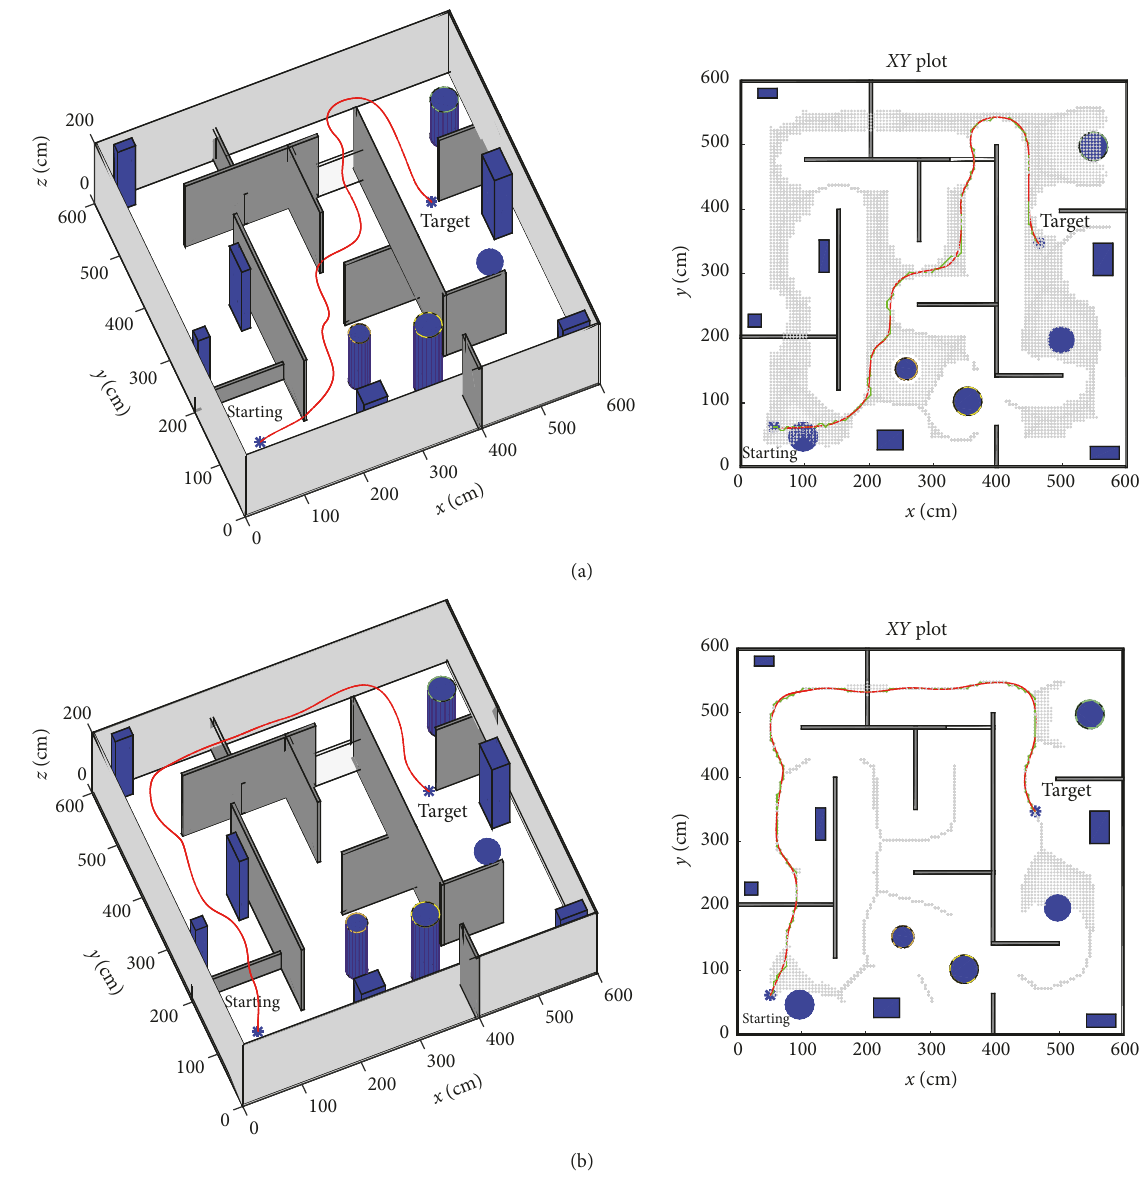
Figure 5: Final path for different UAV sizes (20cm (a), 40cm (b)).